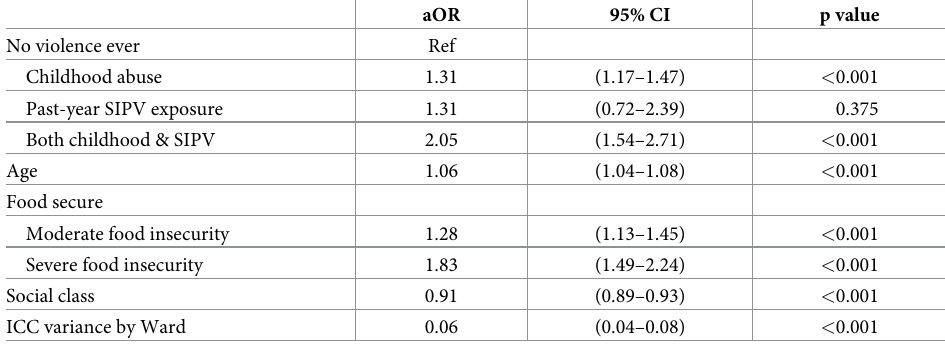
Table 3. Mixed effects model of elevated depressive symptoms in a stratified cluster sample of women ( n =